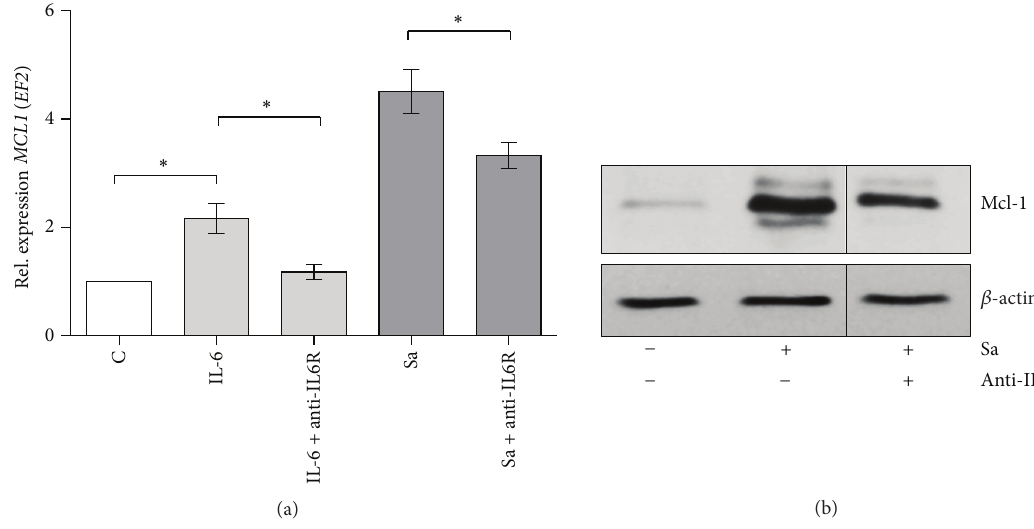
F 5: Mcl-1 expression induced by S. aureus is mediated by IL-6. (a) hMDMs were preincubated with anti-IL6 receptor antibodies (1 g/mL) for 30min and then infected with S. aureus at an MOI of 1:50 and/or stimulated with IL-6 (200ng/mL). At 7h p.i., RNA was extracted and relative MCL1 expression was measured by qRT-PCR. Diagram shows the mean values calculated from the results of at least three independent real-time reactions using hMDMs derived from different donors. Bars represent mean relative expression 𝜇𝜇 (b) hMDMs were preincubated with anti-IL6 receptor (1 g/mL) antibodies for 30min and then infected with S. aureus Newman at an MOI of 1:50. e effect of S. aureus on Mcl-1 protein synthesis was measured 20h aer-infection by immunoblot. Shown is a representative immunoblot from three separate experiments performed on hMDMs derived from different 𝜇𝜇